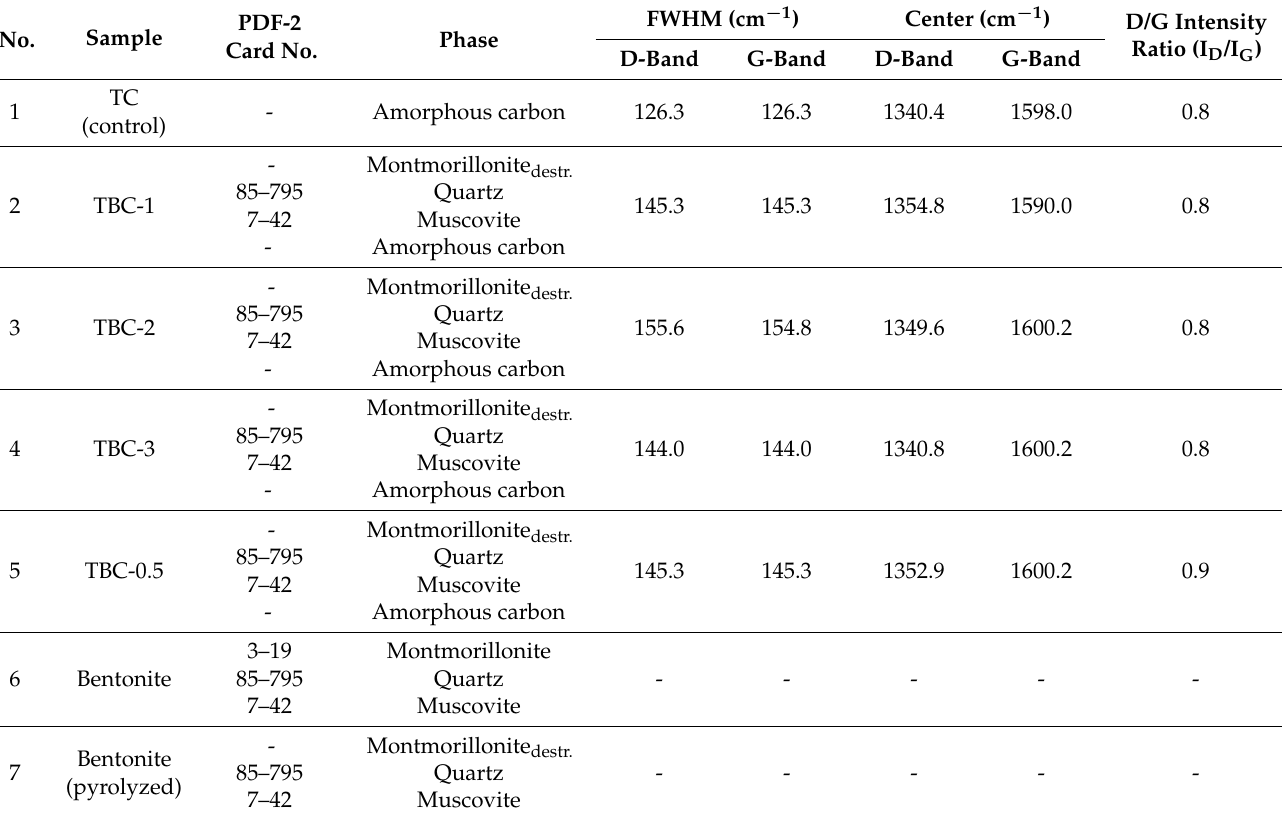
Table 2. Structural characteristics of pyrolyzed tannin–bentonite materials.